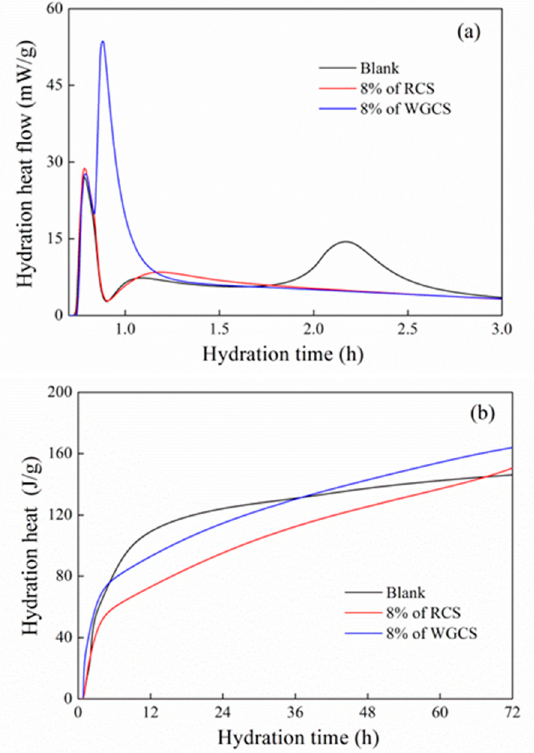
Figure 5. Hydration rate and heat of CS–CSA pastes. ( a ) Hydration heat flow; ( b ) Hydration heat.